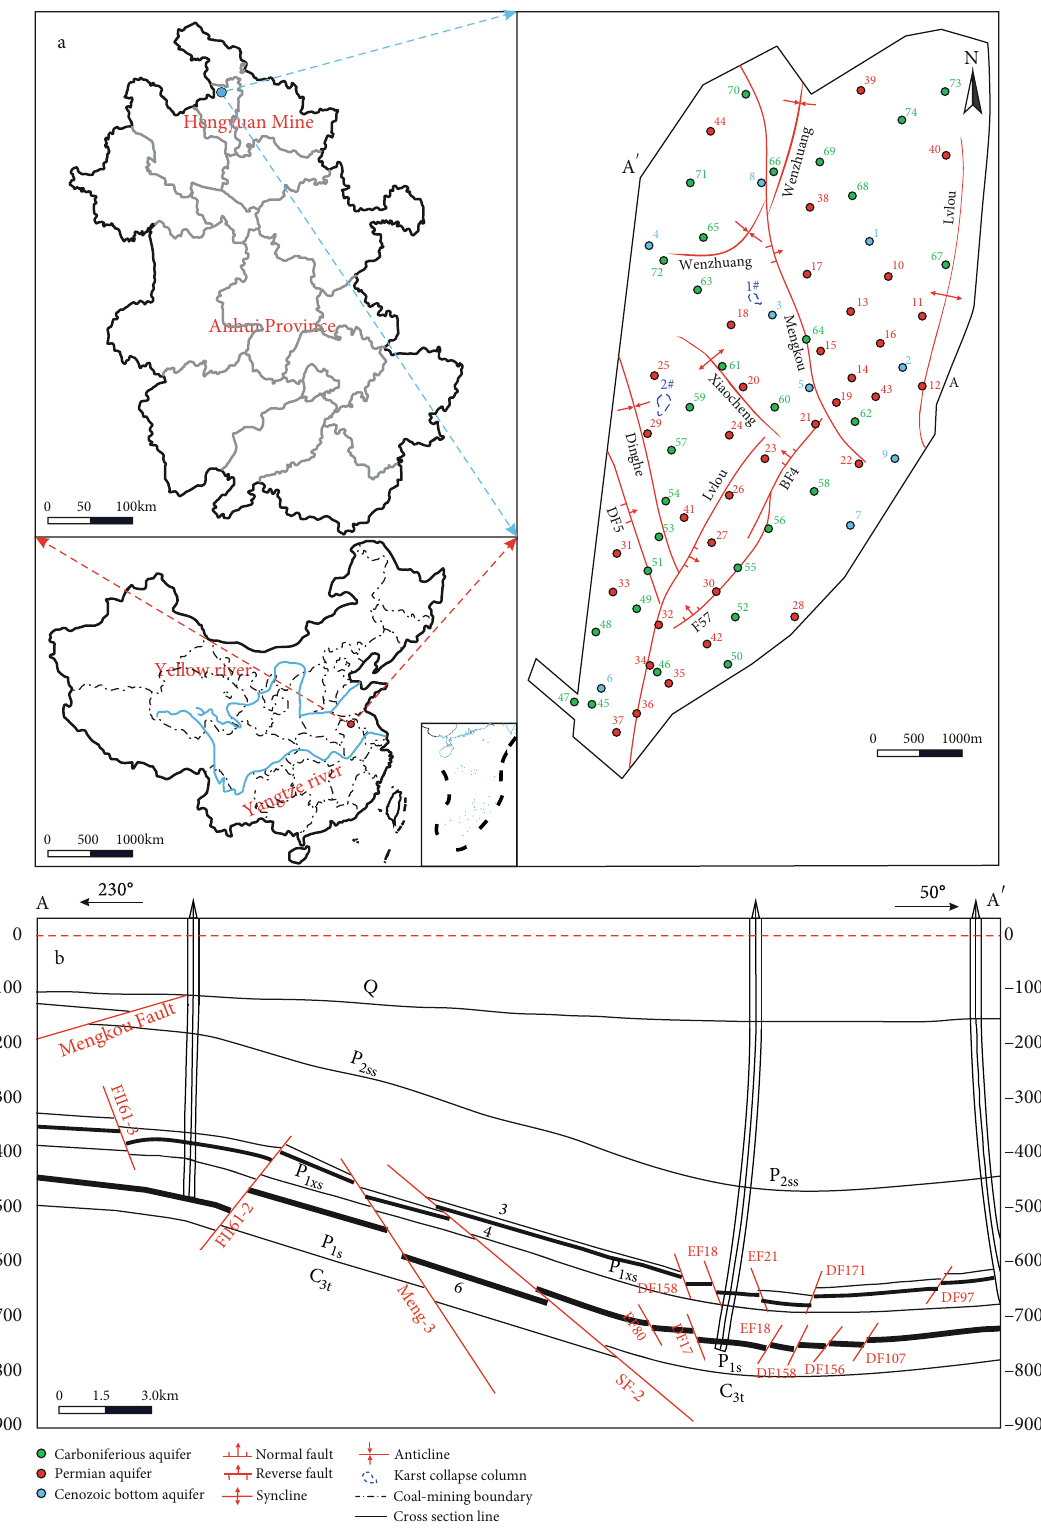
Figure 1: The map of the Hengyuan coal mine area, with the distribution of faults, folds, sampling sites, and cross section of the coal mine along line A –